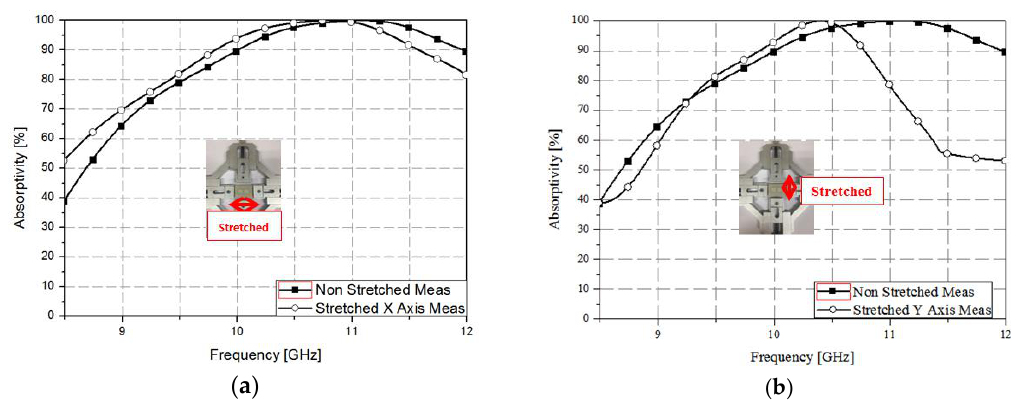
Figure 9. Measured absorption when stretched along ( a ) the x -direction and ( b ) the y -direction.